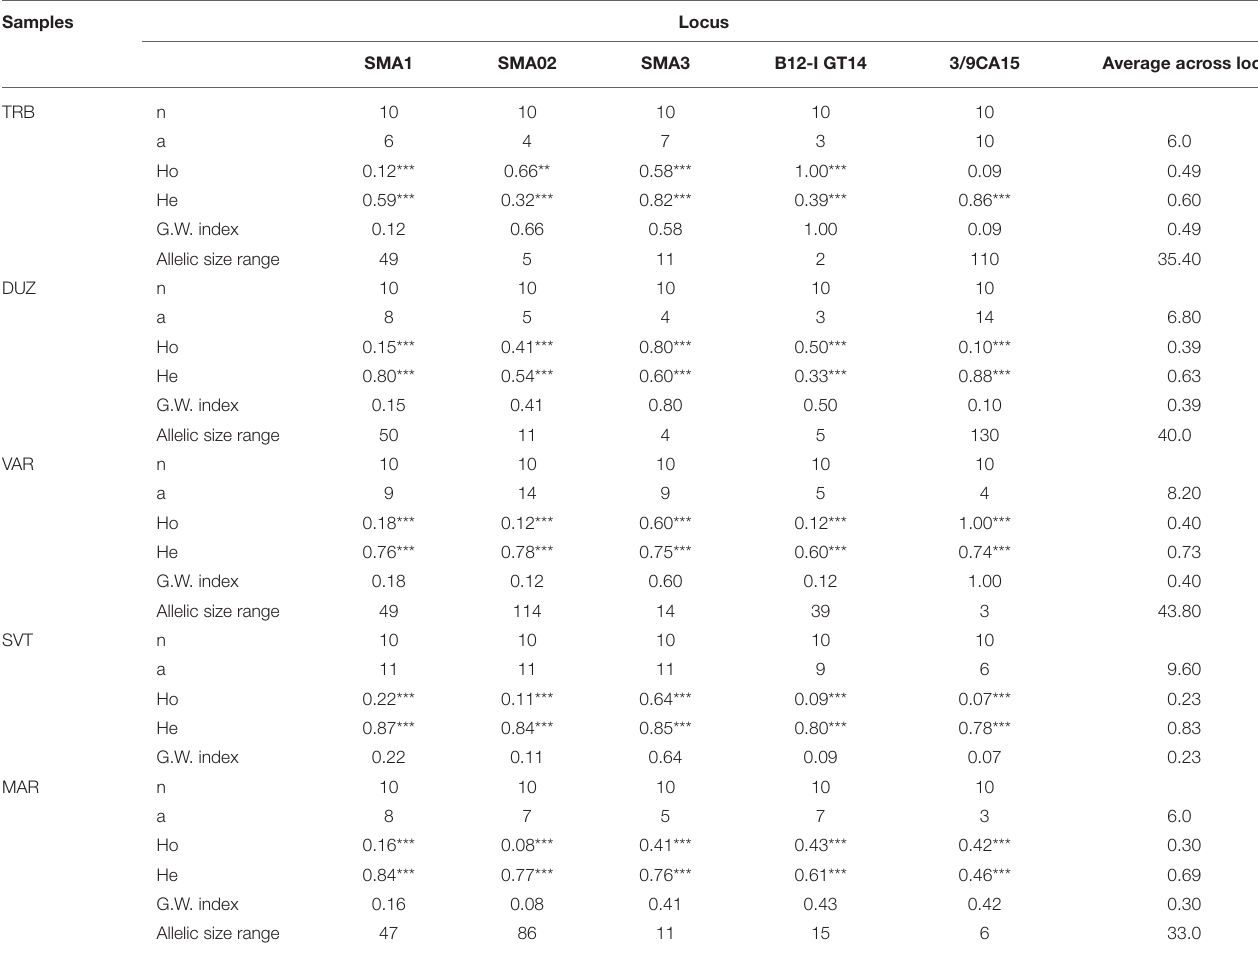
TABLE 2 | Descriptive statistics for five microsatellite loci between the turbot populations. Samples